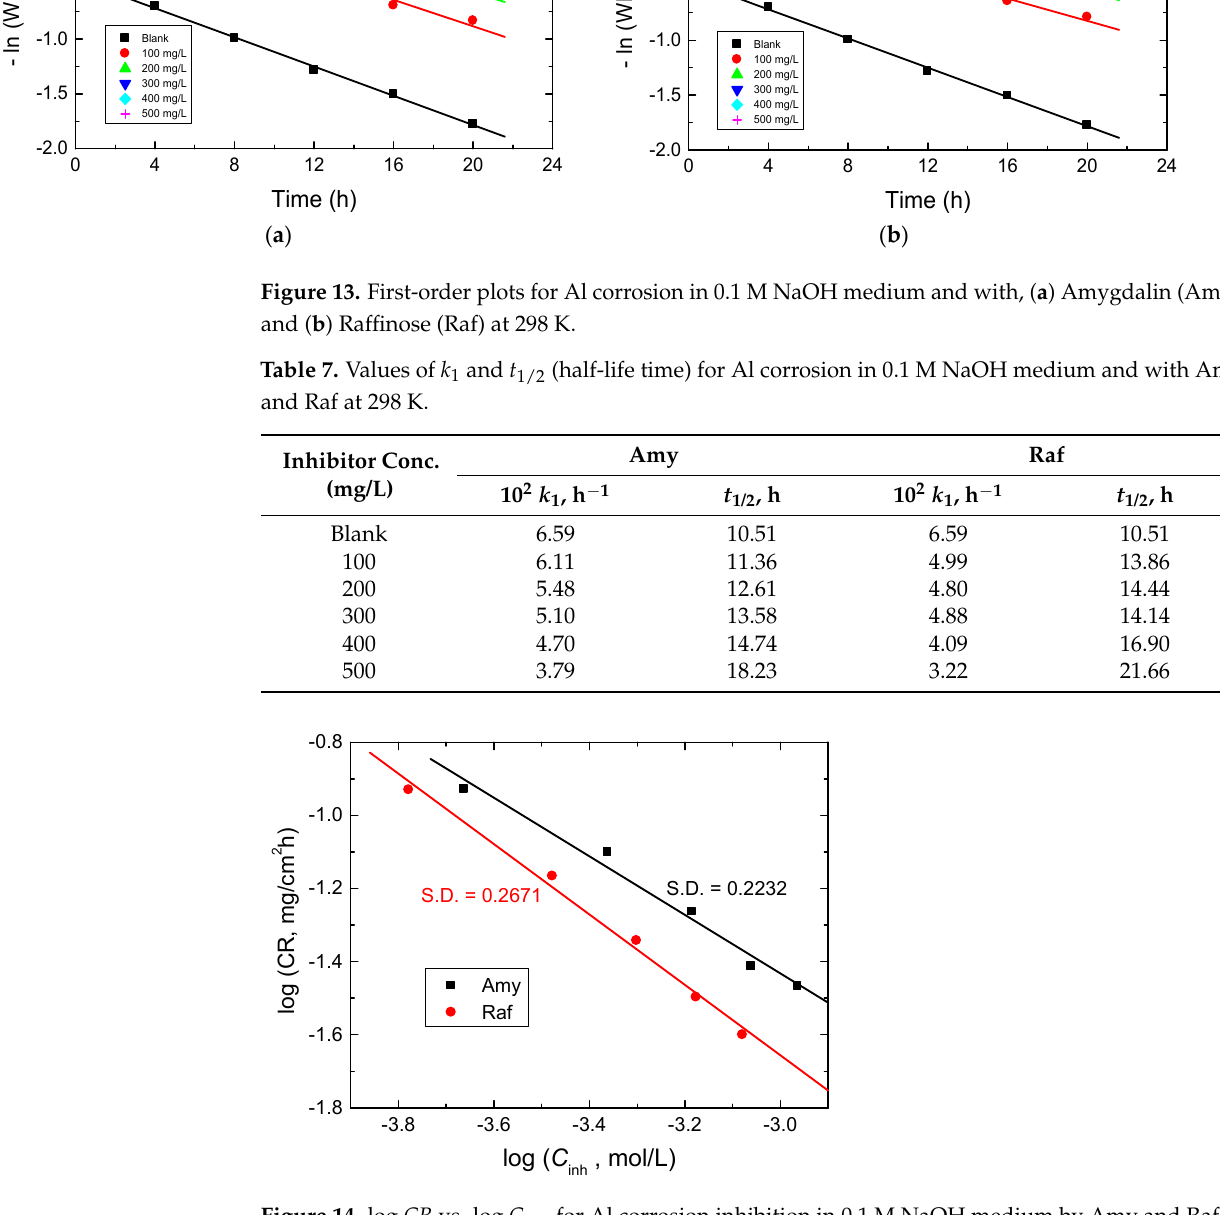
Figure 14. log CR vs. log C inh for Al corrosion inhibition in 0.1 M NaOH medium by Amy and Raf at 298 K. S.D. = standard deviation.